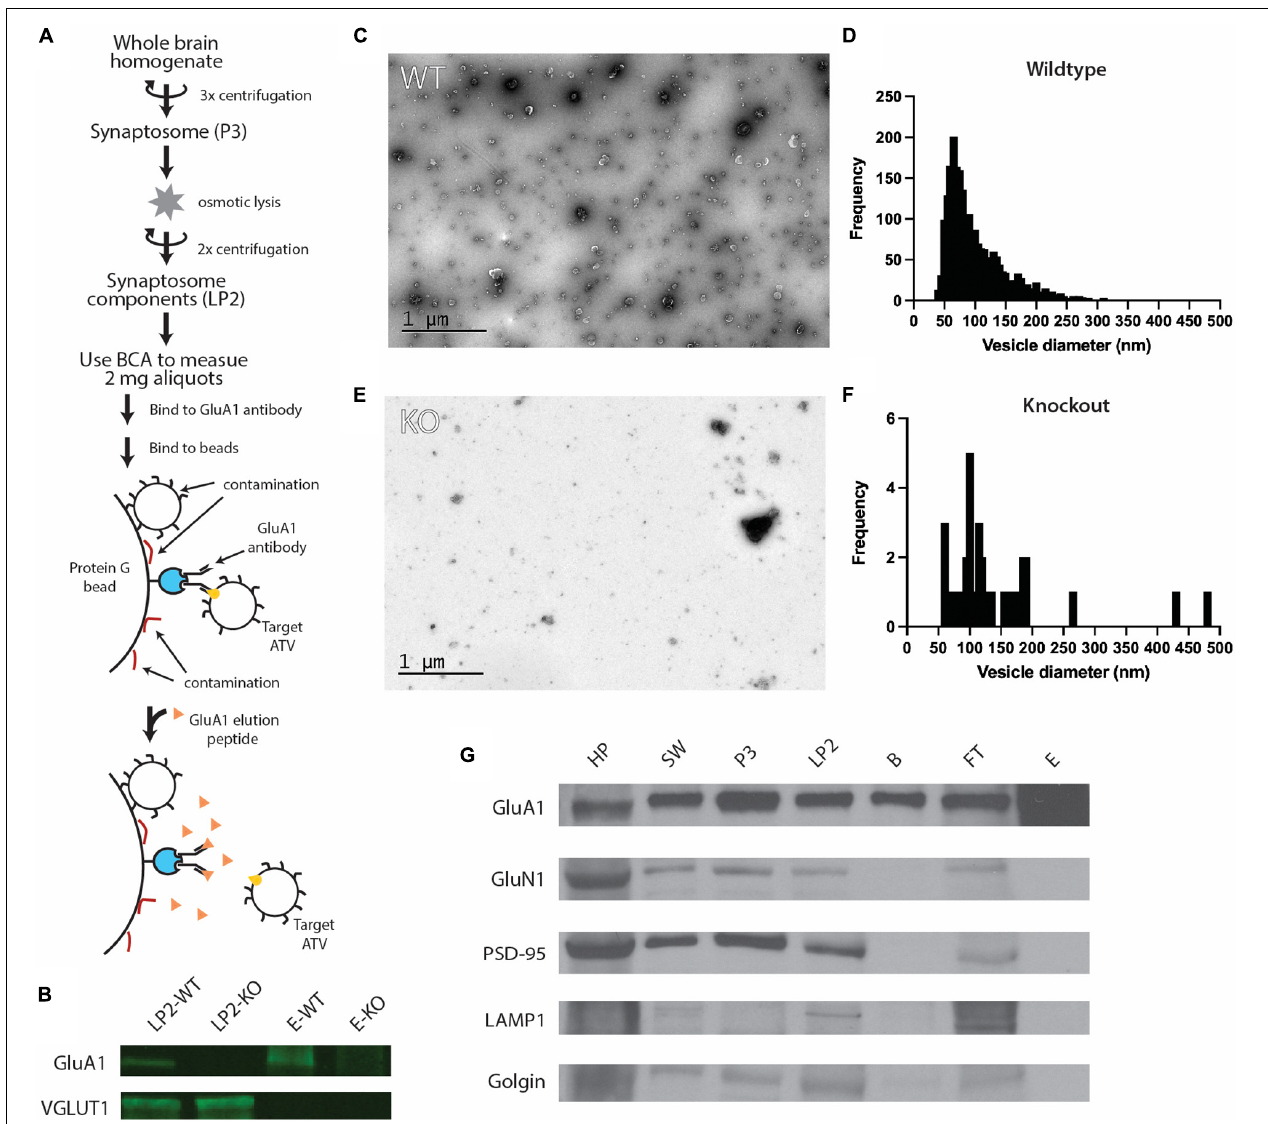
FIGURE 1 | Purification of ACVs from whole mouse brain. (A) Purification protocol for isolating ACVs. At variance to all previous methods, the final step of the preparation involves elution with a GluA1 peptide that corresponds to the epitope of the GluA1 monoclonal antibody. Note that the same amount of protein (as assessed by BCA) was inputted into the same immunoisolation step for both wild-type and knockout preparations. (B) Western blots for GluA1 and VGLUT1 in WT isolated synaptosome content (LP2-WT), GluA1 KO isolated synaptosome content (LP2-KO), GluA1 peptide eluate from wild-type mice (E-WT), and GluA1 peptide eluate from GluA1 KO mice (E-KO). Original blots provided in Supplementary Figure 1 . (C) Negative stain electron microscopy image of GluA1 peptide eluate of wild-type mice. Additional images are shown in Supplementary Figure 2 . All images are provided as Source Data. (D) Histogram of vesicle diameters from wild-type eluate from three independent immunoisolations. (E) Negative stain electron microscopy image of GluA1 peptide eluate of GluA1 KO mice. Additional images are shown in Supplementary Figure 3 . Additional images are provided in Supplementary Material . (F) Histogram of vesicle diameters from knockout eluate from three independent immunoisolations. (G) Representative western blots from three independent immunoisolations for GluA1 (102 kD), GluN1 (115 kD), PSD-95 (98 kD), LAMP1 (130 kD), and Golgin (100 kD) for homogenized whole brain pellet (HP), the second synaptosome wash step (SW), synaptosome (P3), synaptosome content (LP2), beads from immunoisolation prior to elution (B) , flowthrough from immunoisolation (FT), and GluA1-peptide eluate off beads (E) for wild-type mice. Original blots provided in Supplementary Figure 4